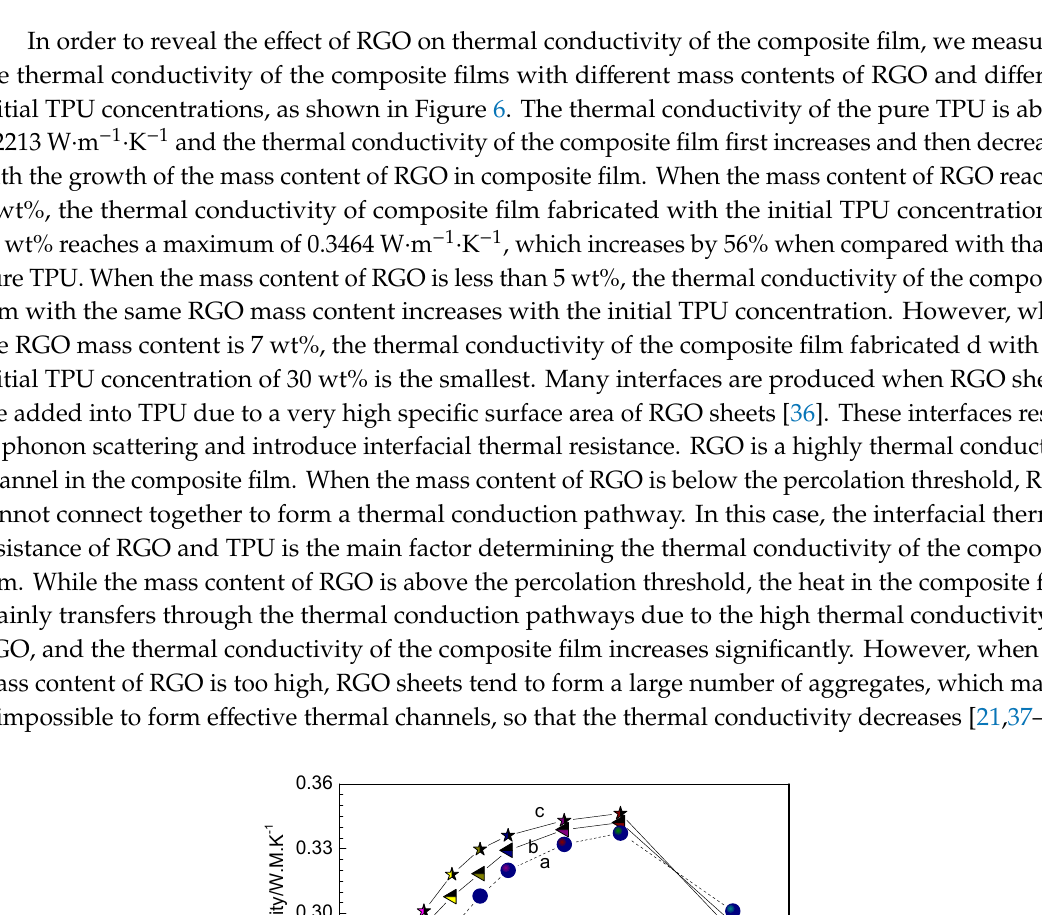
Figure 5. SEM images of the cross-section morphology of the composite films prepared with the initial TPU concentration of 20 wt% and the graphene mass content of 1.5 wt% ( a ), 3.0 wt% ( b ), and 5.0 wt% ( c ), respectively. ( c ), respectively.